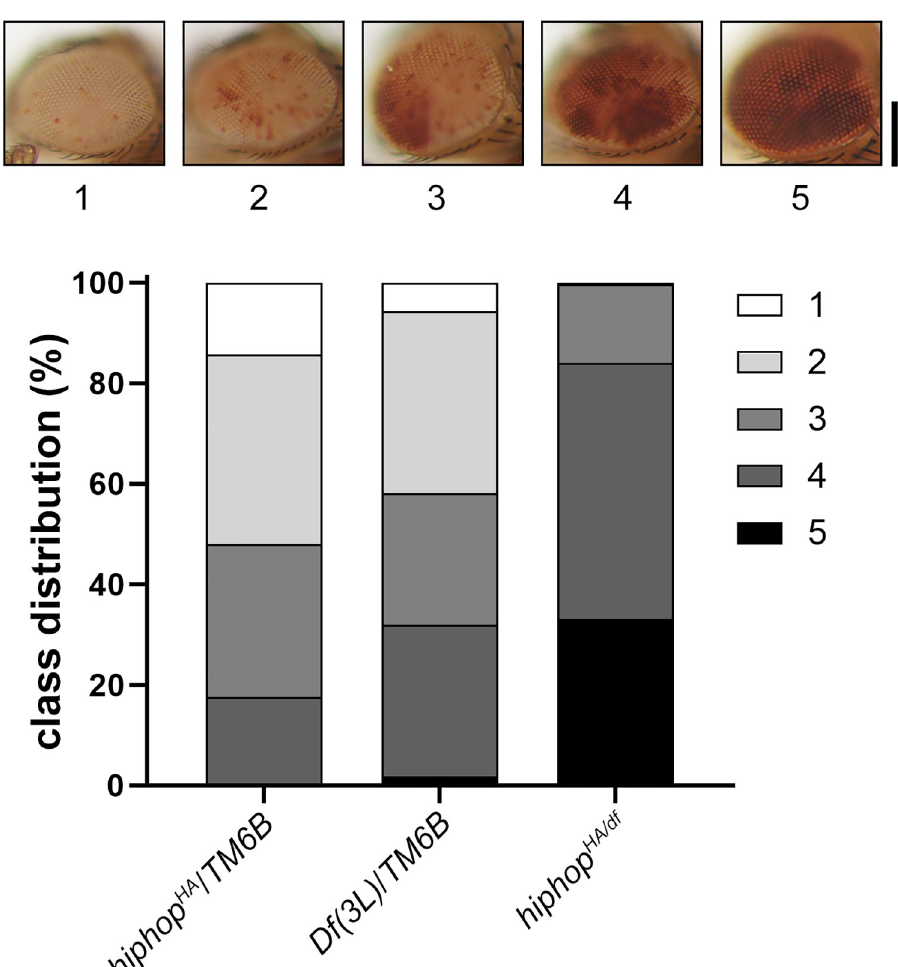
Fig 8. hiphop HA is a recessive suppressor of PEV. At the top are images of eyes from females with the genotype of In (1)w m4h /w 1118 showing various degrees of eye pigmentation. The degree is given a number of 1 to 5 according to the extent of pigmentation. At the bottom is the quantification of eye pigmentation from hiphop mutant females and their two kinds of heterozygous sisters. Scale bar indicates